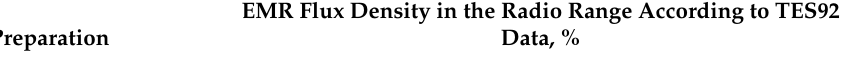
Table 3. Specificity of thermal radio emission activation using the example of monoclonal antibodies to various RBD epitopes of the SARS-CoV-2 virus. The aliquot of each drug was 100 µ L. The concentration of antibodies was 10 µ g/mL. 100% EMR flux density corresponds to 28 ± 3 µ W/m 2 (t = 23 ◦ C) for 2E1 * antibodies (without lighting, t = 23 ◦ C) with the background (control, t = 23 ◦ C) of 1.3 ± 0.4 µ W/ m 2 .